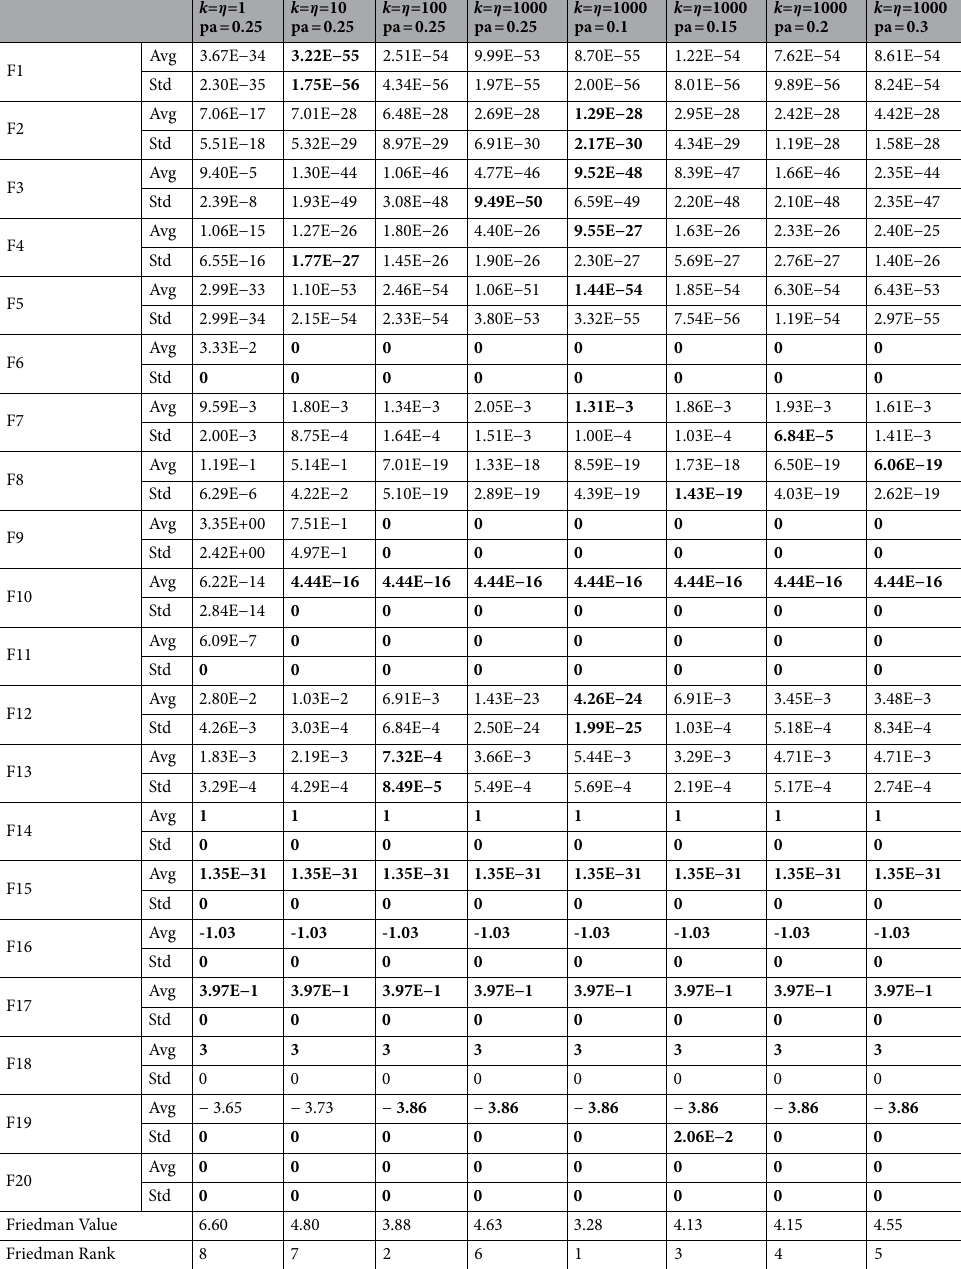
Table 10. Statistical Test for parameter combination with dimension = 30 . Significant values are in bold.